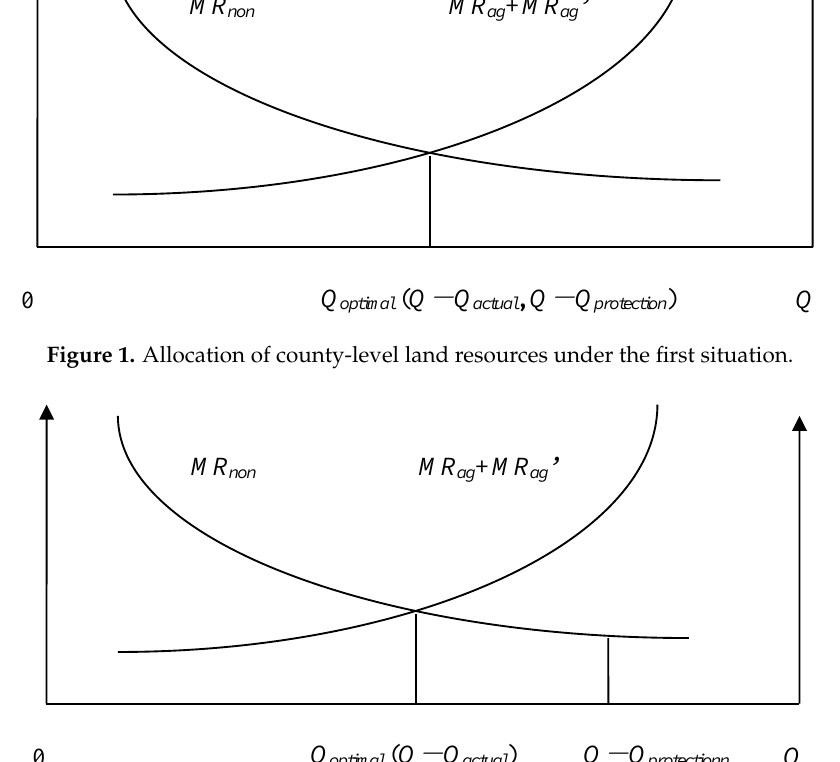
Figure 2. Allocation of county-level land resources under the second situation.